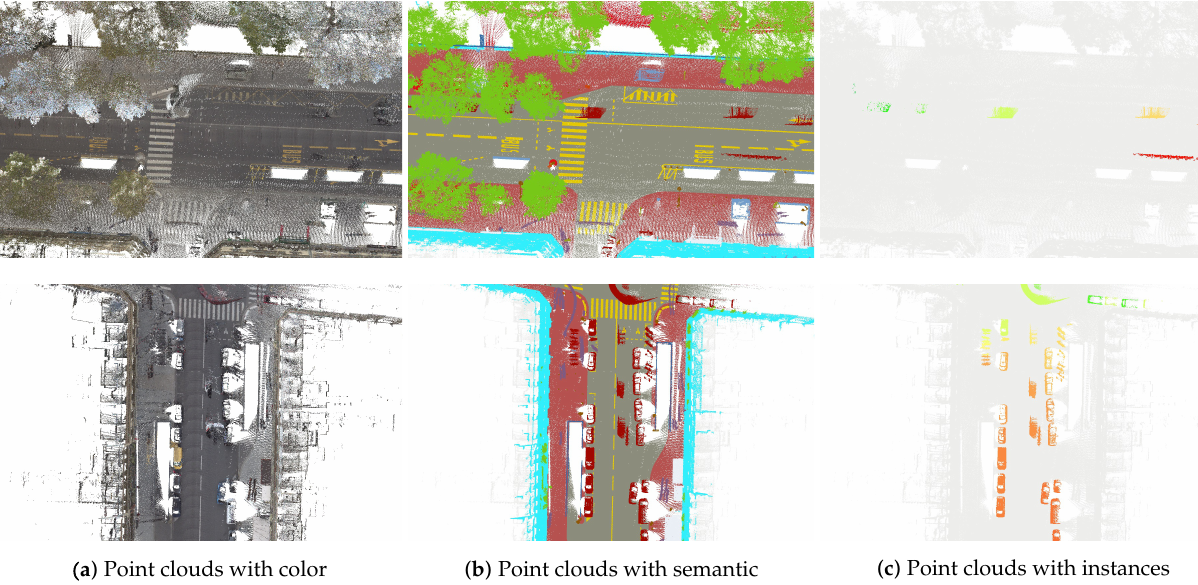
Figure A3. Paris Test set . From top to bottom: S 0 , S 3 (real data). Figure A3. Paris test set. From top to bottom : S 0 , S 3 (real